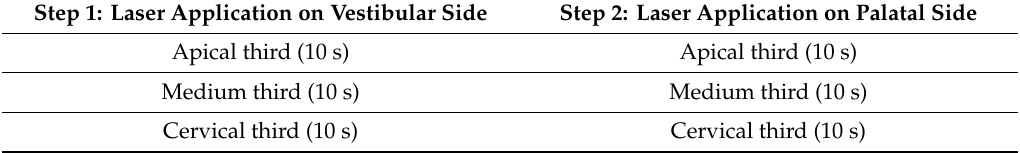
Table 1. PBMT protocol performed on the vestibular and palatal sides of the canine’s root for a total of six points for the laser application. The same protocol was repeated on days 3, 7, and 14. PBMT